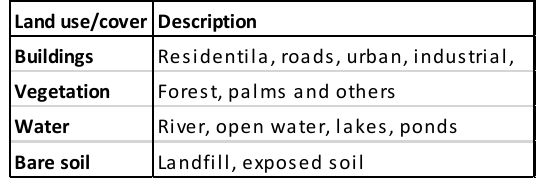
Table 1: Land use/cover